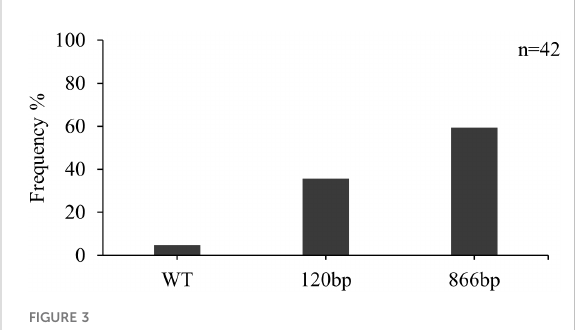
FIGURE 3 Frequency of inserts in the promoter region of the CYP51 gene (%) in Z. tritici isolates from Lithuania in 2021.